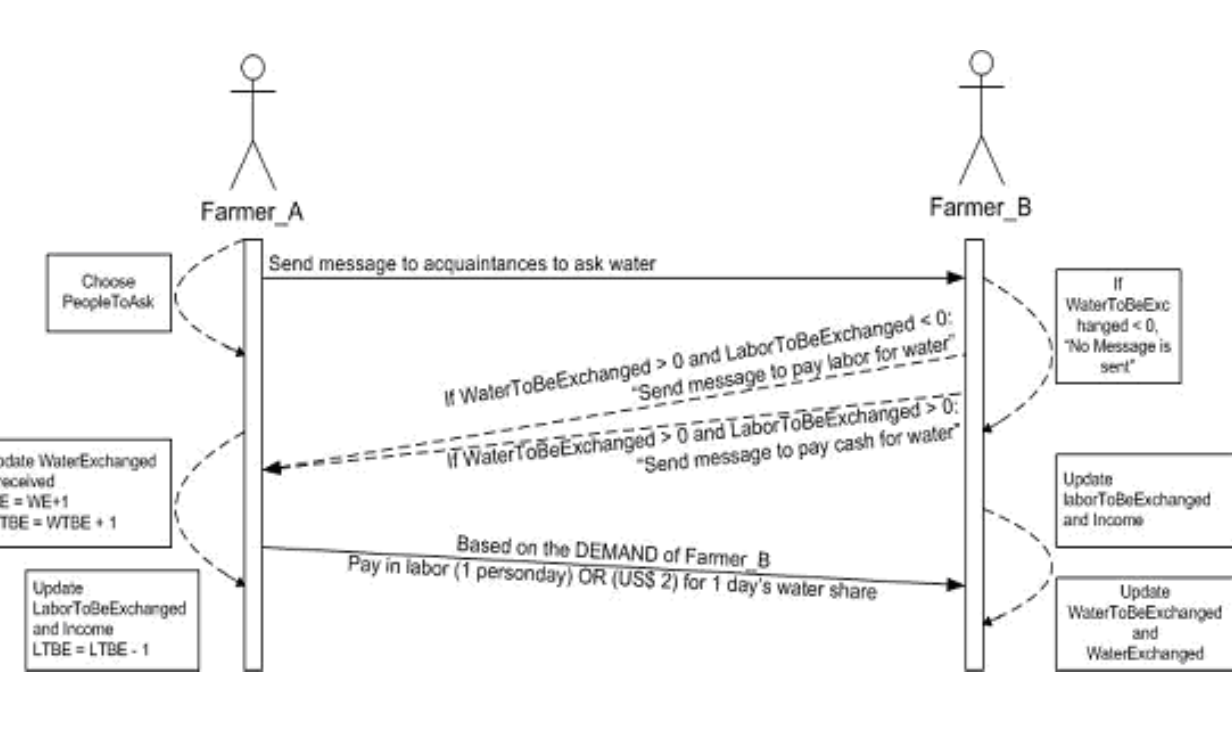
Fig. A2.5. Protocol for exchange of water and labor in the Limbukha